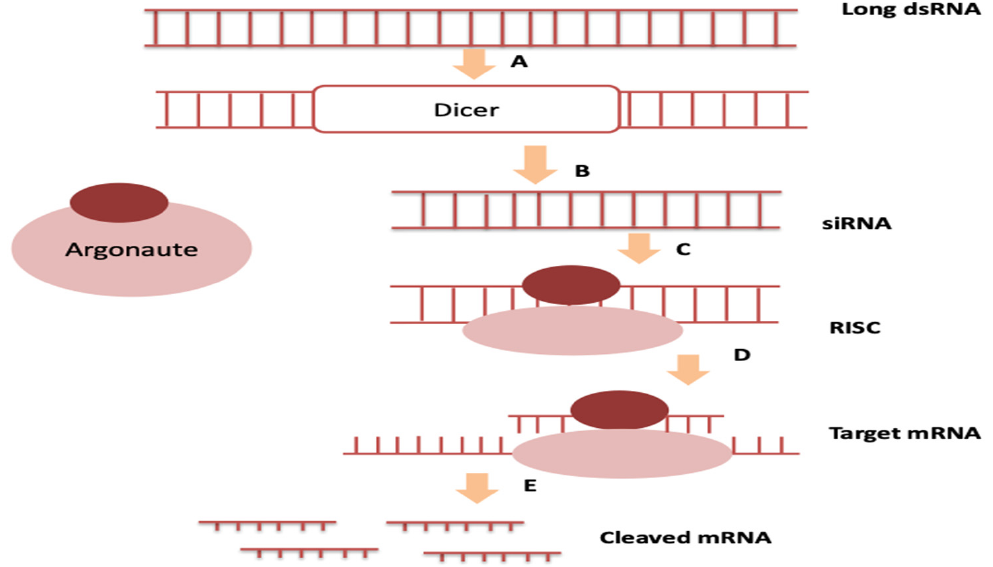
Figure 1. mRNA silencing by RNA interference. A–B. Cleavage of long dsRNA precursors by RNase III endonuclease Dicer to form smaller fragments, referred as siRNA. B–C. These short dsRNAs are subsequently unwound and the guide strand is assembled into RNA-induced silencing complex (RISC), that contains Argonaute protein (catalytic component) to cleave the passenger strand. C–D. RISC containing the guide strand will form complementary base sequence. D–E. The sequential will result in mRNA cleavage and degradation.